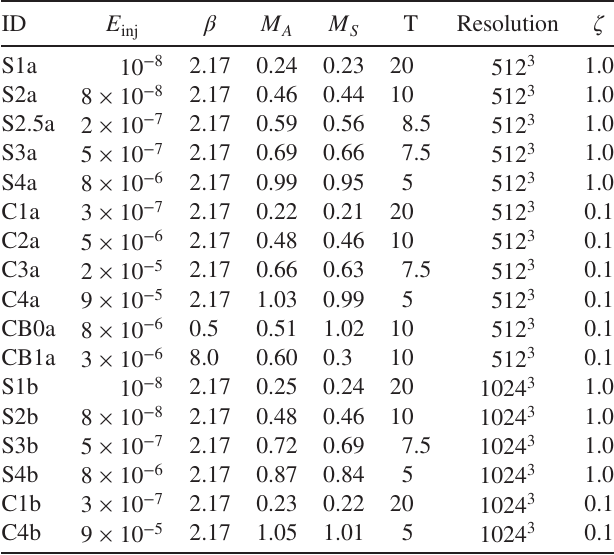
lation IDs. The energy injection rate E , the plasma β , Alfv´en inj Mach number M A , sonic Mach number M S , the forcing corre- lation time T , resolution, and fraction of compressive driving ζ are varied amongst the different simulation